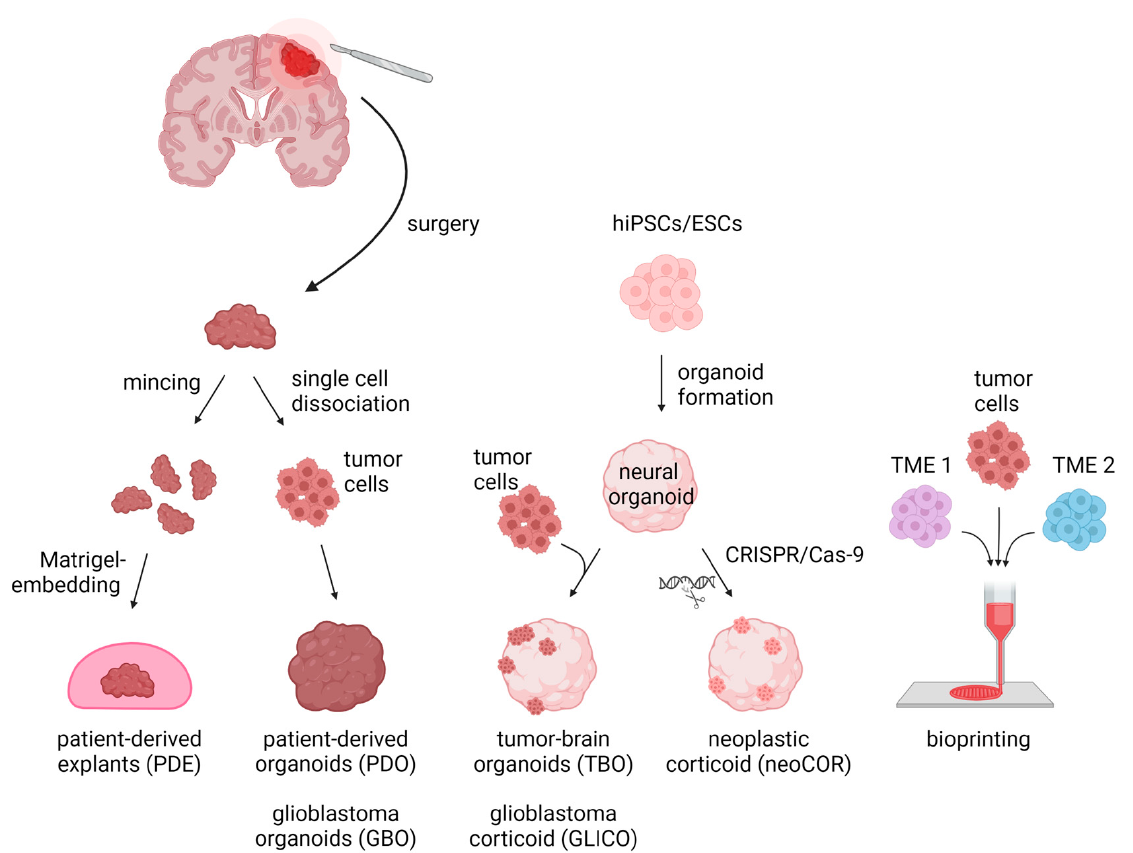
Figure 1. Three-dimensional in vitro tumor models can be derived from either primary patient materials or generated de novo from pluripotent stem cells. PDEs and PDOs are derived from patients’ resected tumor tissue, which is minced and Matrigel-embedded for PDE generation or is single-cell dissociated followed by re-aggregation for PDOs/GBOs. TBOs/GLICOs and neoCORs are generated by seeding hiPSCs/ESCs for organoid generation, followed by co-culture with tumor cells for TBOs/GLICOs or CRISPR-Cas9-based gene editing for neoCORs. To create 3D models via bioprinting, tumor cells are loaded together with TME cells into a bioink and spatially printed. Abbreviations: PDE: patient-derived explant; PDO: patient-derived tumor organoid; GBO; glioblastoma organoid; TBO: tumor-brain organoid; GLICO: glioblastoma corticoid; neoCOR: neoplastic corticoid; 3D: three- dimensional; hiPSC: human induced pluripotent stem cell; ESC: embryonic stem cell; TME1/2: tumor microenvironment cell type 1 or 2. Created with BioRender.com (accessed on 7 November 2022). In contrast to traditional mono-layer and spheroid cultures, organoids across all mod- els can preserve intra- and intertumoral heterogeneity [23,29,37] and establish